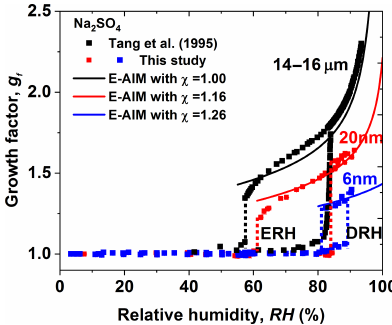
Figure 9. Mobility diameter hygroscopic growth factors ( g f ) and deliquescence and efflorescence relative humidity (DRH and ERH; red and blue dashed lines) of sodium sulfate nanoparticles with a dry diameter of 20nm, (red squares) and 6nm, (blue squares), re- spectively. Black squares and black dashed lines show the respec- tive results from Tang et al. (1995) with electrodynamic balance (EDB), respectively. In this study, the black, red, and blue curves show the E-AIM predictions, including the Kelvin effect and shape factors ( χ)